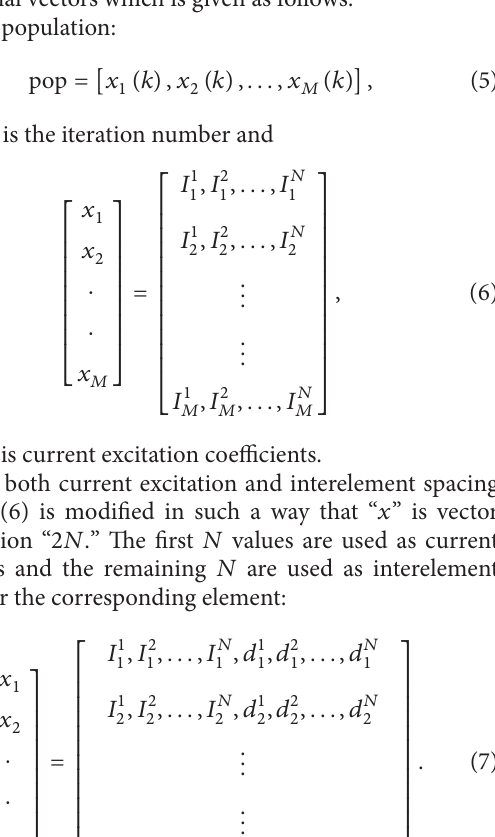
Case 1 (nonuniform amplitude distribution with uniform spacing and without beam steering). In this case, SLL suppression is observed using only amplitude adjustments. radiation pattern. Radiation pattern pertaining to CAA of 20 and 40 isotropic elements is as shown in Figures 3(a) and 3(b), respectively. The effectiveness of the algorithm (solid line) can be analysed when compared with the radiation pattern (RP) of GA (dotted) and uniform CAA (dotted line) in these figures. The algorithm consistently produced SLL of − 25 dB even for a change in number of elements which is better than − 7 dB as in the case of UCAA. Case 2 (nonuniform amplitude distribution with uniform spacing and with main beam steering). In this case, the main